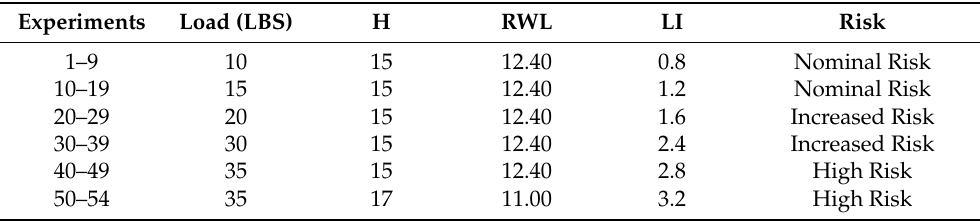
Table 3. Variable Weights used in the Experiments to Calculate the RWL and